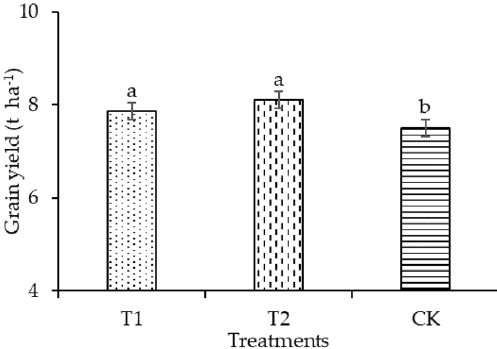
Figure 9. Grain yield under different treatments.